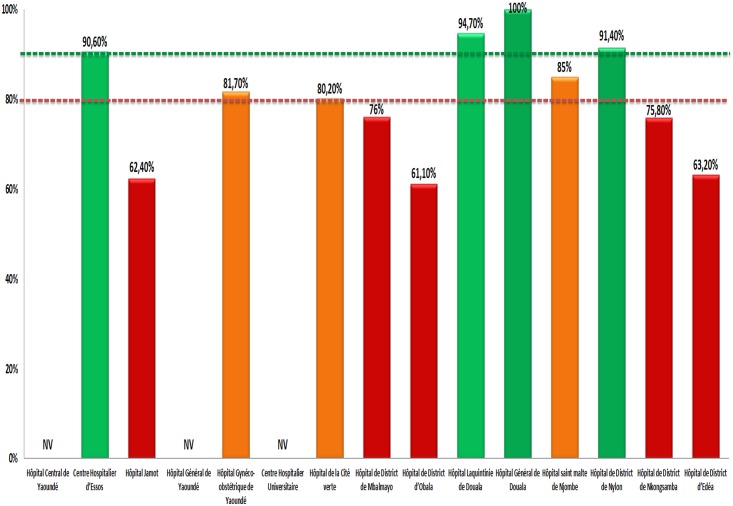
Site Performance for “On-time Pill Pick-up” in 2013.NV, Not Validated; green, desirable performance; amber, fair performance; red, poor performance. Horizontal lines indicate the lower limit thresholds for “desirable” (in “green” color) and for “fair” (in “amber” color) performance.